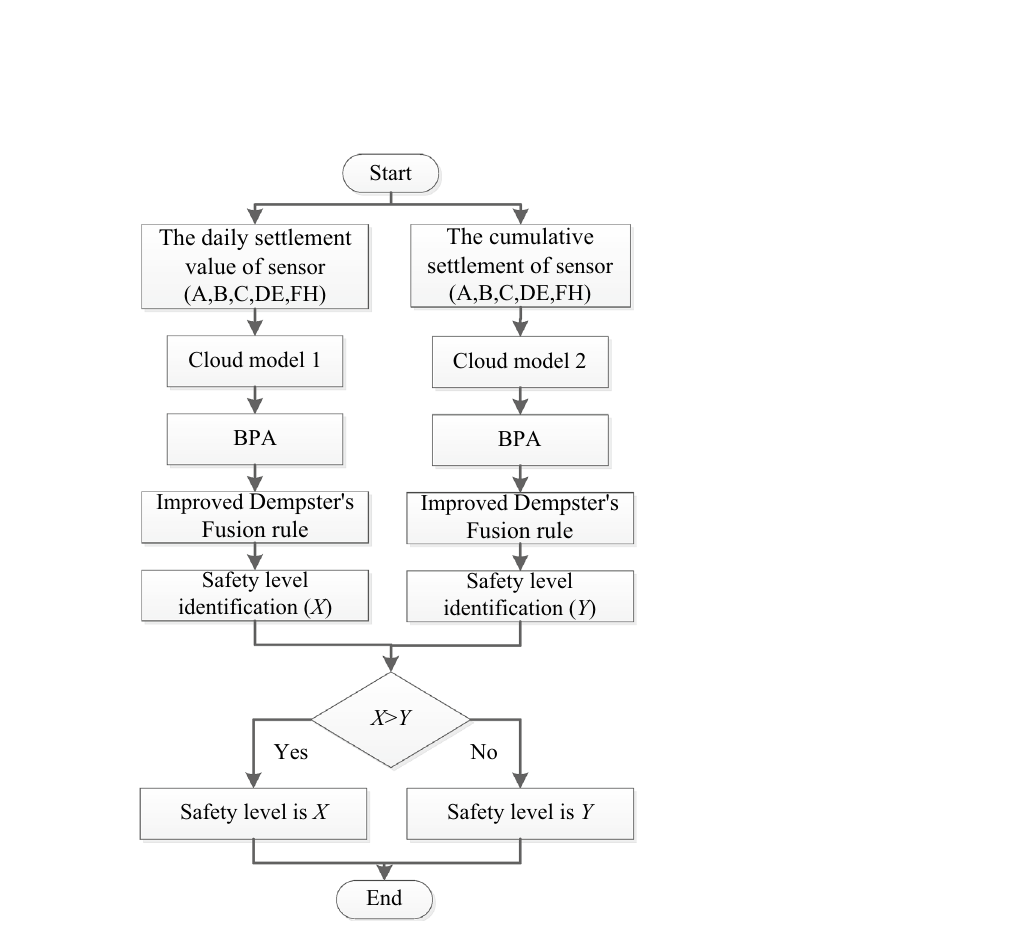
Figure 6. Flowchart of monitoring data